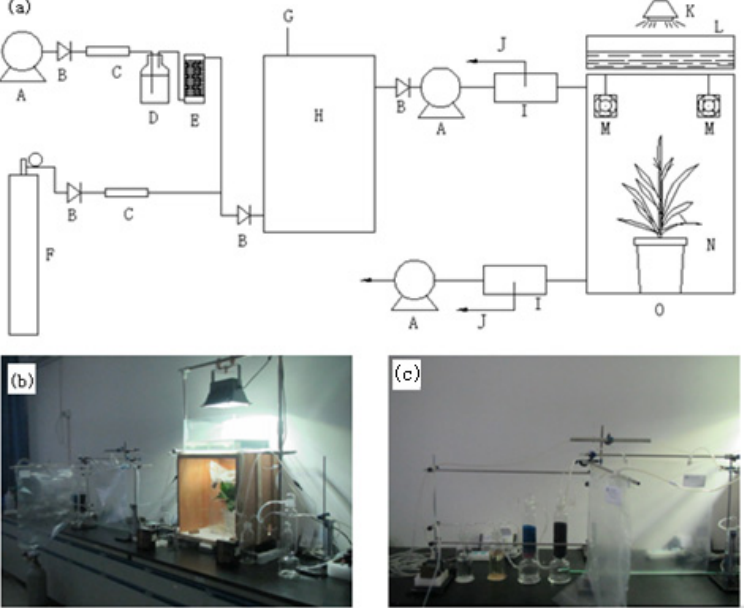
Figure 1. Scheme ( a ) and pictures ( b , c ) of the experimental apparatus for measuring the removal